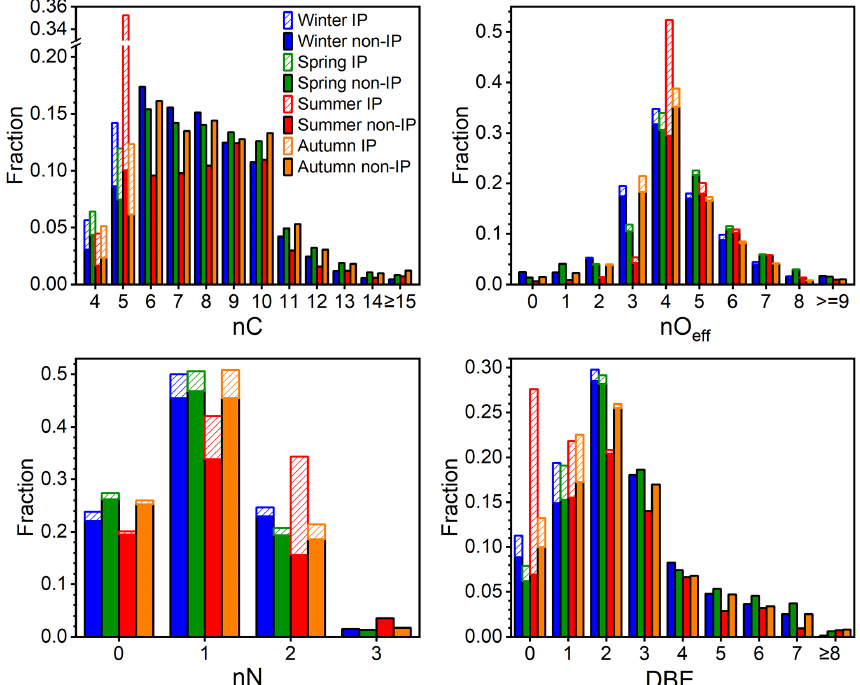
Figure 3. The number of carbon (nC), effective oxygen (nO eff ), nitrogen (nN), and double bond equivalence (DBE) distributions of OOMs for four seasons. The abbreviations IP and non-IP represent IP OOMs and other non-isoprene OOMs, respectively. The bars with diagonal lines and filled colors represent IP OOMs and non-isoprene OOMs,